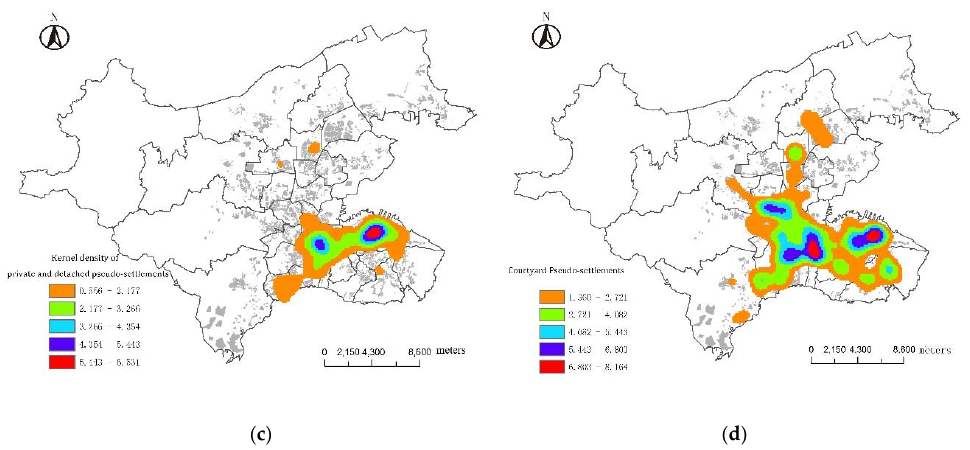
Figure 2. Spatial features of pseudo ‐ architecture of human settlements in Dalian. ( a ) Private and detached pseudo ‐ buildings; ( b ) High ‐ rise pseudo ‐ buildings; ( c ) Pseudo ‐ building clusters in vast residential quarters; ( d ) Country pseudo ‐ building clusters.